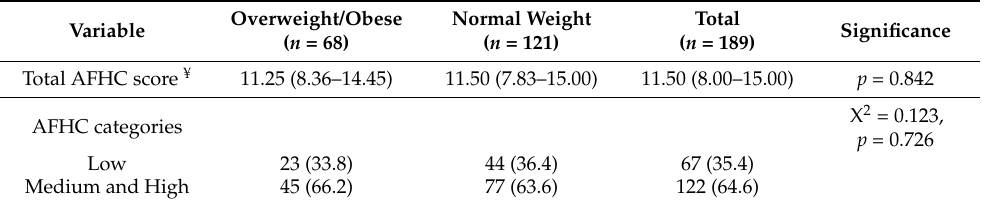
Table 4. Distribution of unhealthy eating habits among participants under study by BMI status ( n = 189).